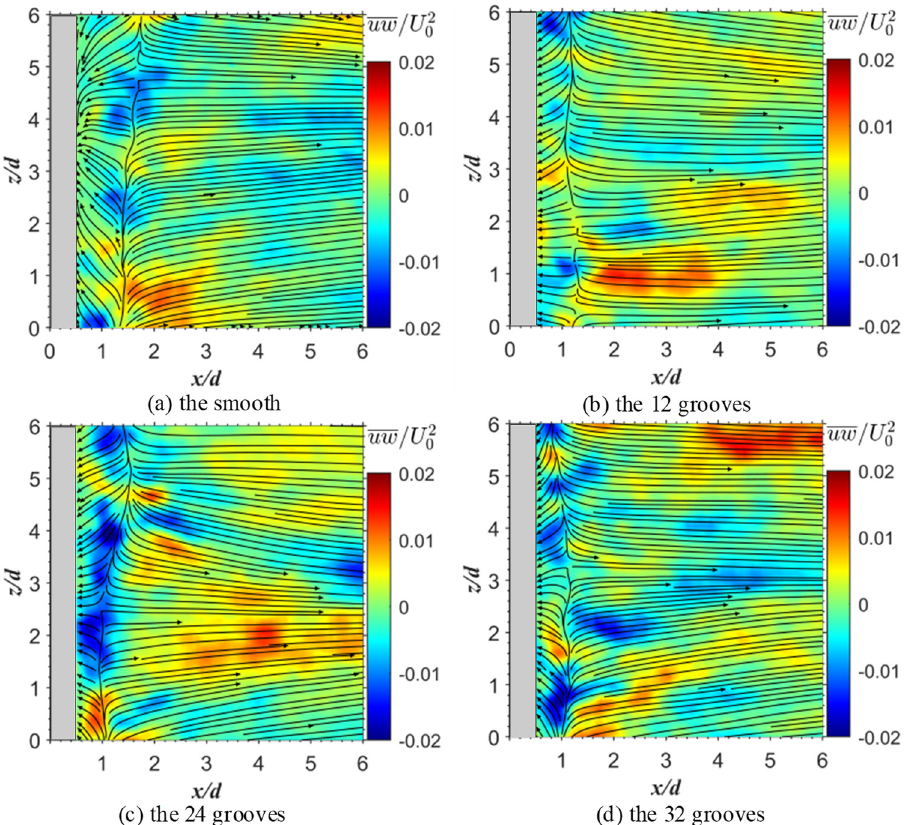
Figure 8. Time-averaged streamlines and Reynolds shear stress distributions in the ( x, z )-plane.